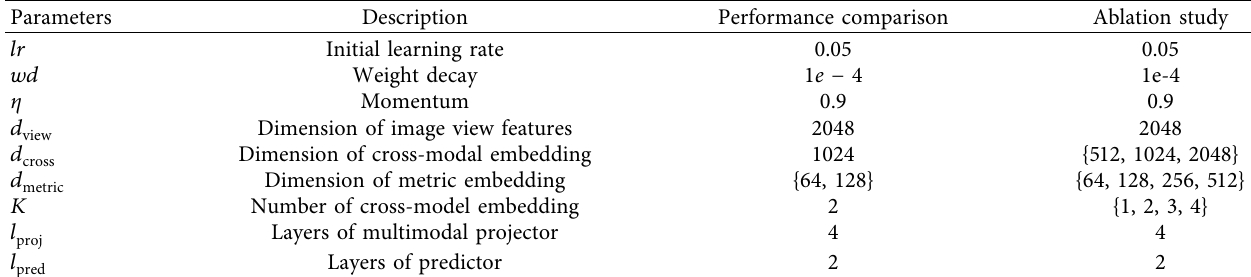
Table 2: Hyperparameters set in